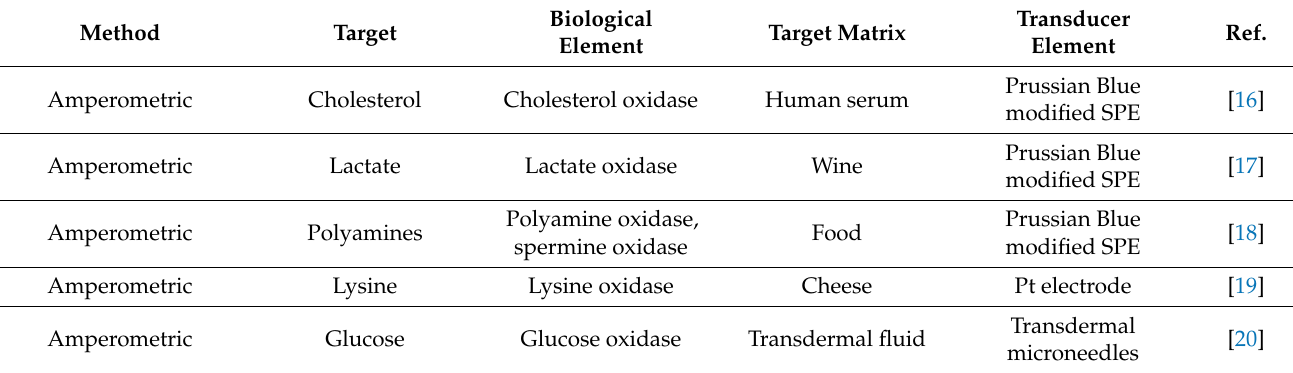
Table 1. List of electrochemical biosensors along with their